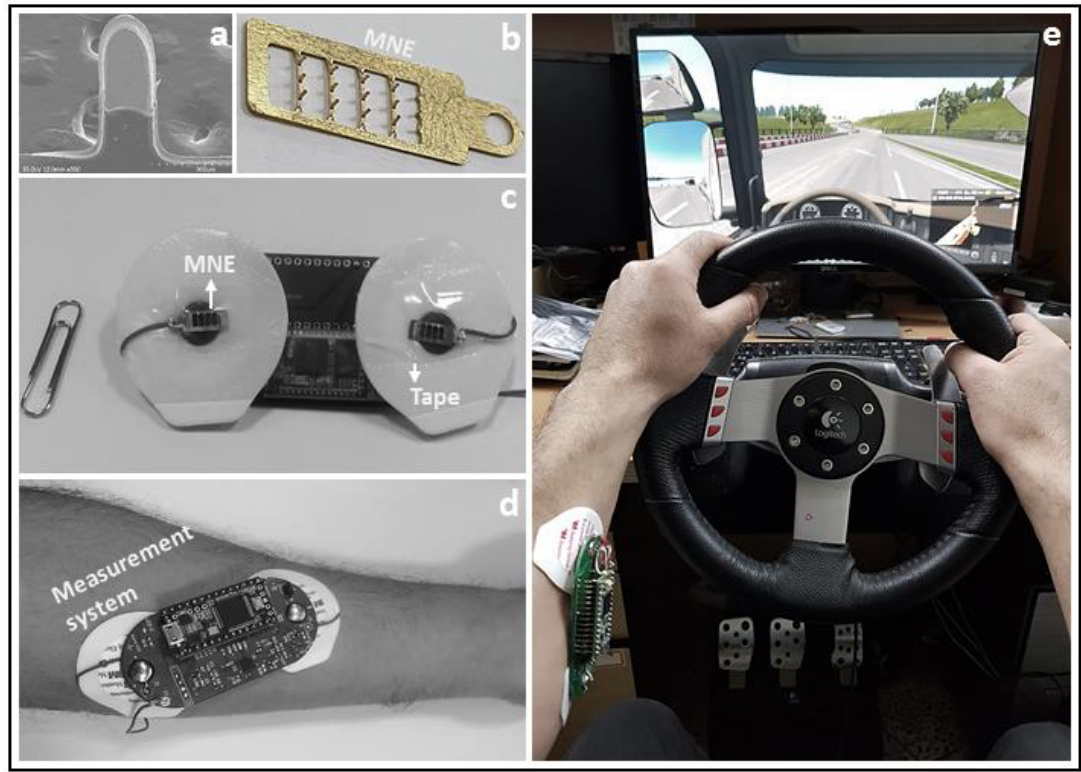
Figure 1. ( a ) SEM image of a single microneedle; ( b ) MNE; ( c ) MNE attached with adhesive dressing for skin contact; ( d ) Measurement system with MNE placed on forearm position; ( e ) Driving simulation system with display.